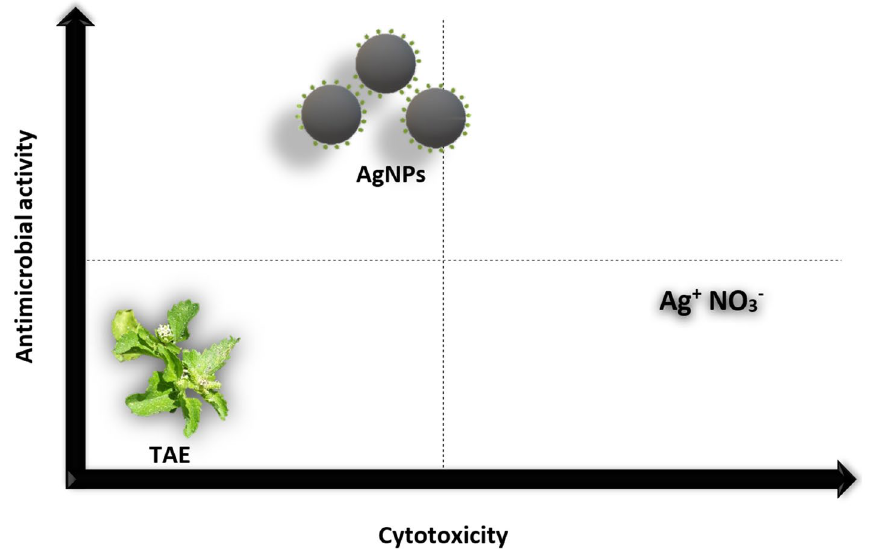
Figure 3. Graphical representation of antimicrobial and cytotoxic activity of TAE, AgNO 3 and AgNPs. Only the synthesized AgNPs showed high antimicrobial activity with moderate cytotoxicity compared to TAE and AgNO 3